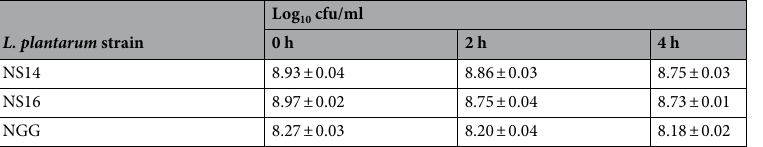
Table 2. Viable cells (log 10 cfu/ml) of L. plantarum strains in the presence of 0.5% bile salts. The mean of three values ± SD are presented.